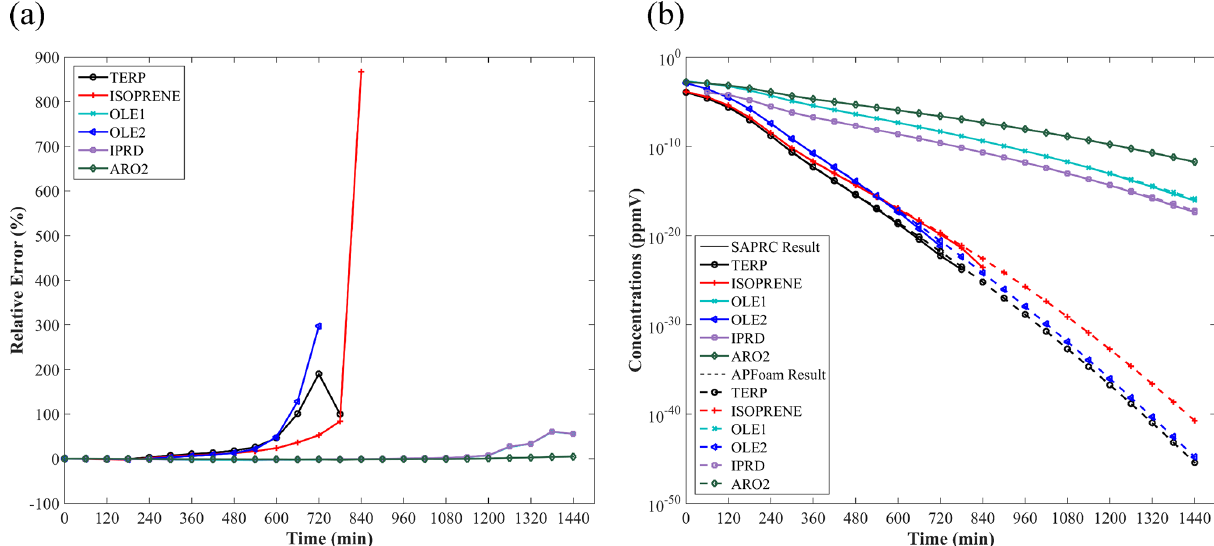
Figure 3. The time series of (a) relative error (%) and (b) concentrations (ppmv) of the six species with largest bias.